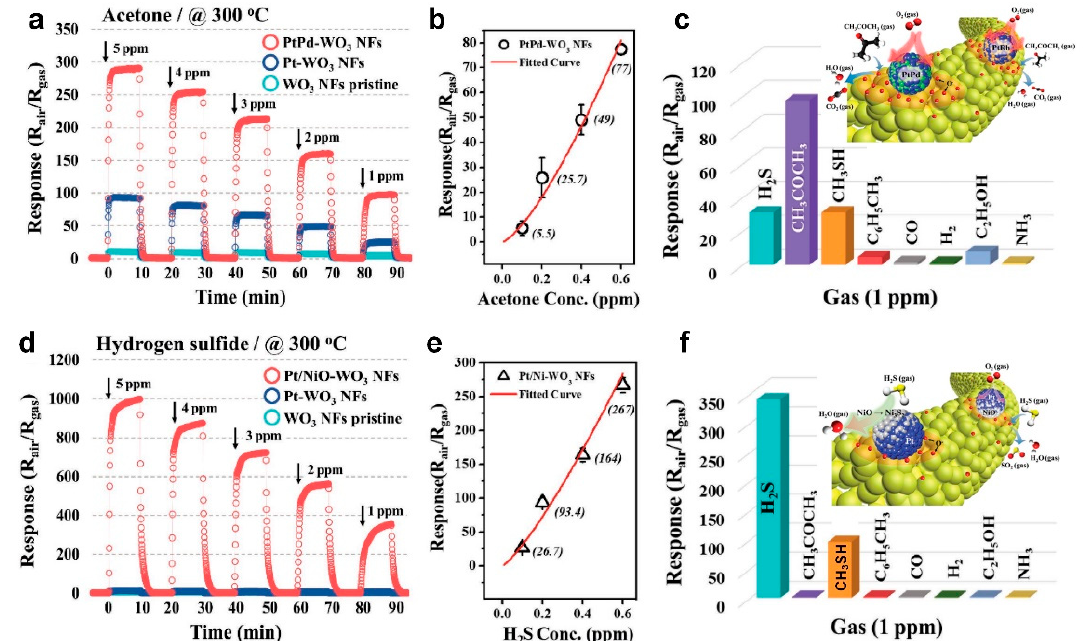
Figure 9. Dynamic gas-sensing properties of pristine WO 3 NFs, Pt-, PtPd-, PtRh-, and Pt/NiO-WO 3 NFs. Acetone sensing property of the PtPd-WO 3 NFs at 300 °C: ( a ) response property in concentration ranges of 1 to 5 ppm, ( b ) limit of detection, ( c ) selective property toward 1 ppm as well as the response towards seven interfering gases: hydrogen sulfide (H 2 S), methyl mercaptan (CH 3 SH), toluene (C 6 H 5 CH 3 ), carbon monoxide (CO), hydrogen (H 2 ), ethanol (C 2 H 5 OH), and ammonia (NH 3 ). Hydrogen sulfide sensing property of the Pt/NiO-WO 3 NFs at 300 °C: ( d ) response property in concentration ranges of 1 to 5 ppm, ( e ) limit of detection, and ( f ) selective property toward 1 ppm as well as the response toward seven interfering gases [59].